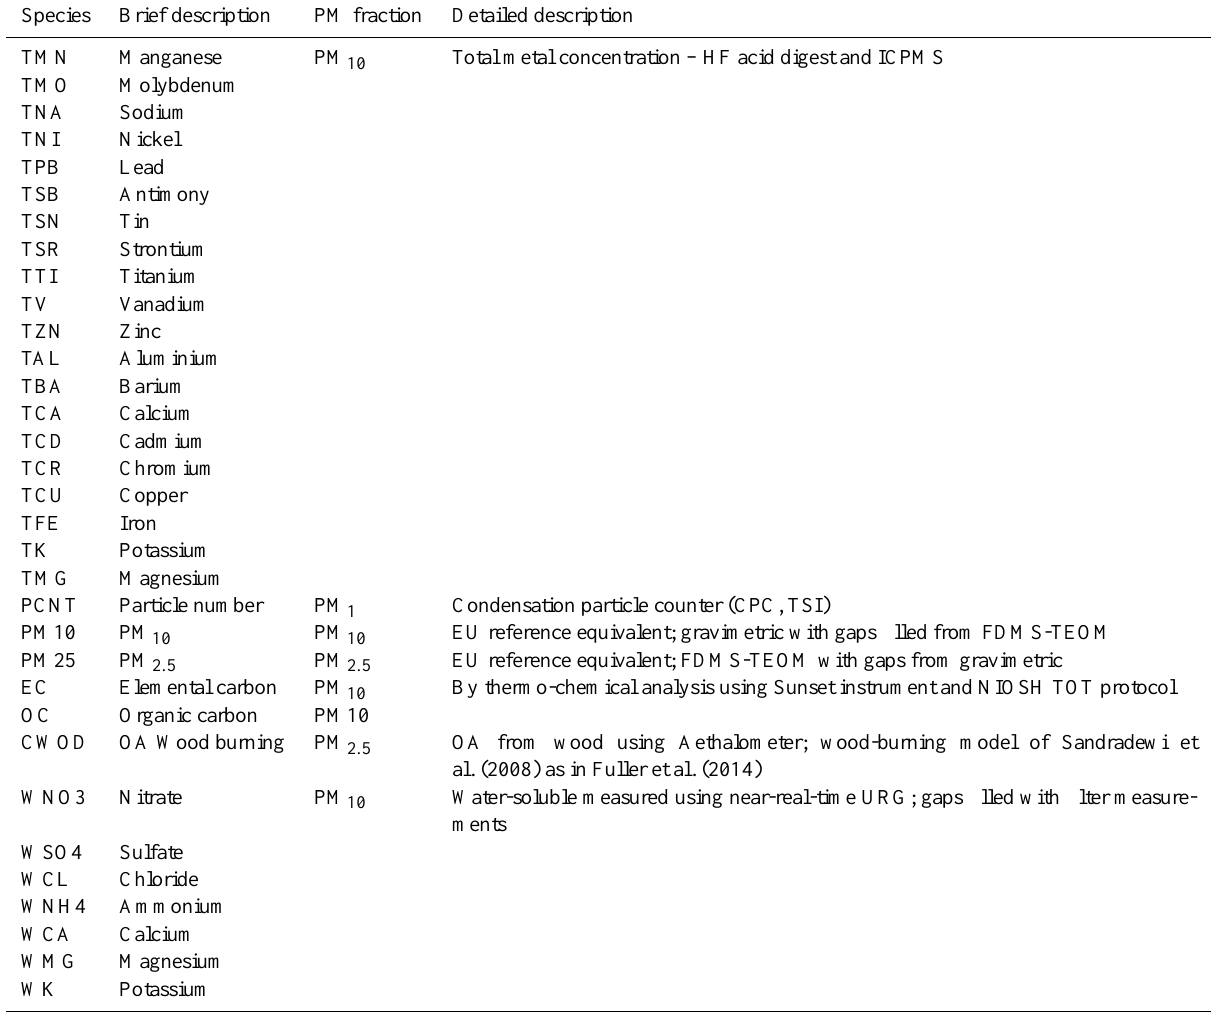
Table 1. Measurements collected at the North Kensington site, 2011 and 2012. Species PM fraction Detailed